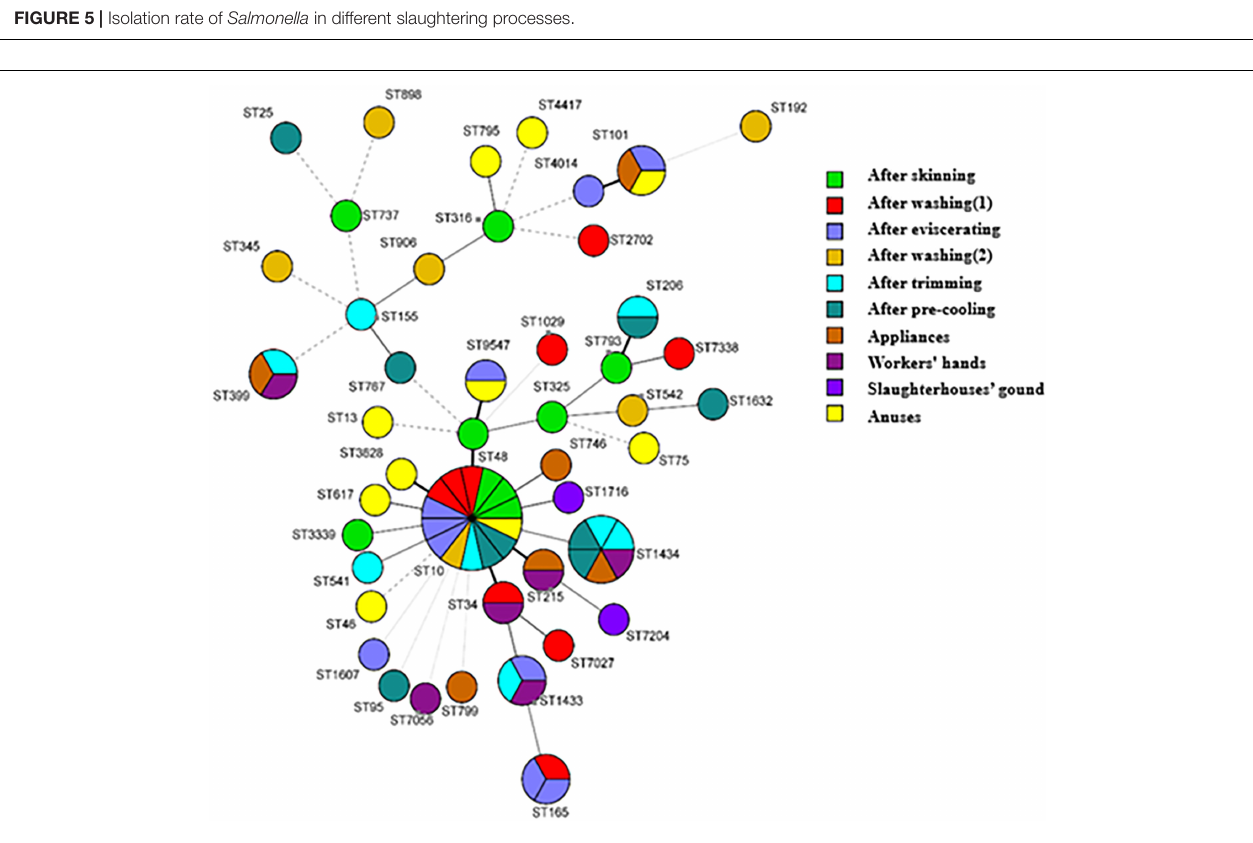
FIGURE 6 | The minimum spanning tree of 51 strains of Escherichia coli